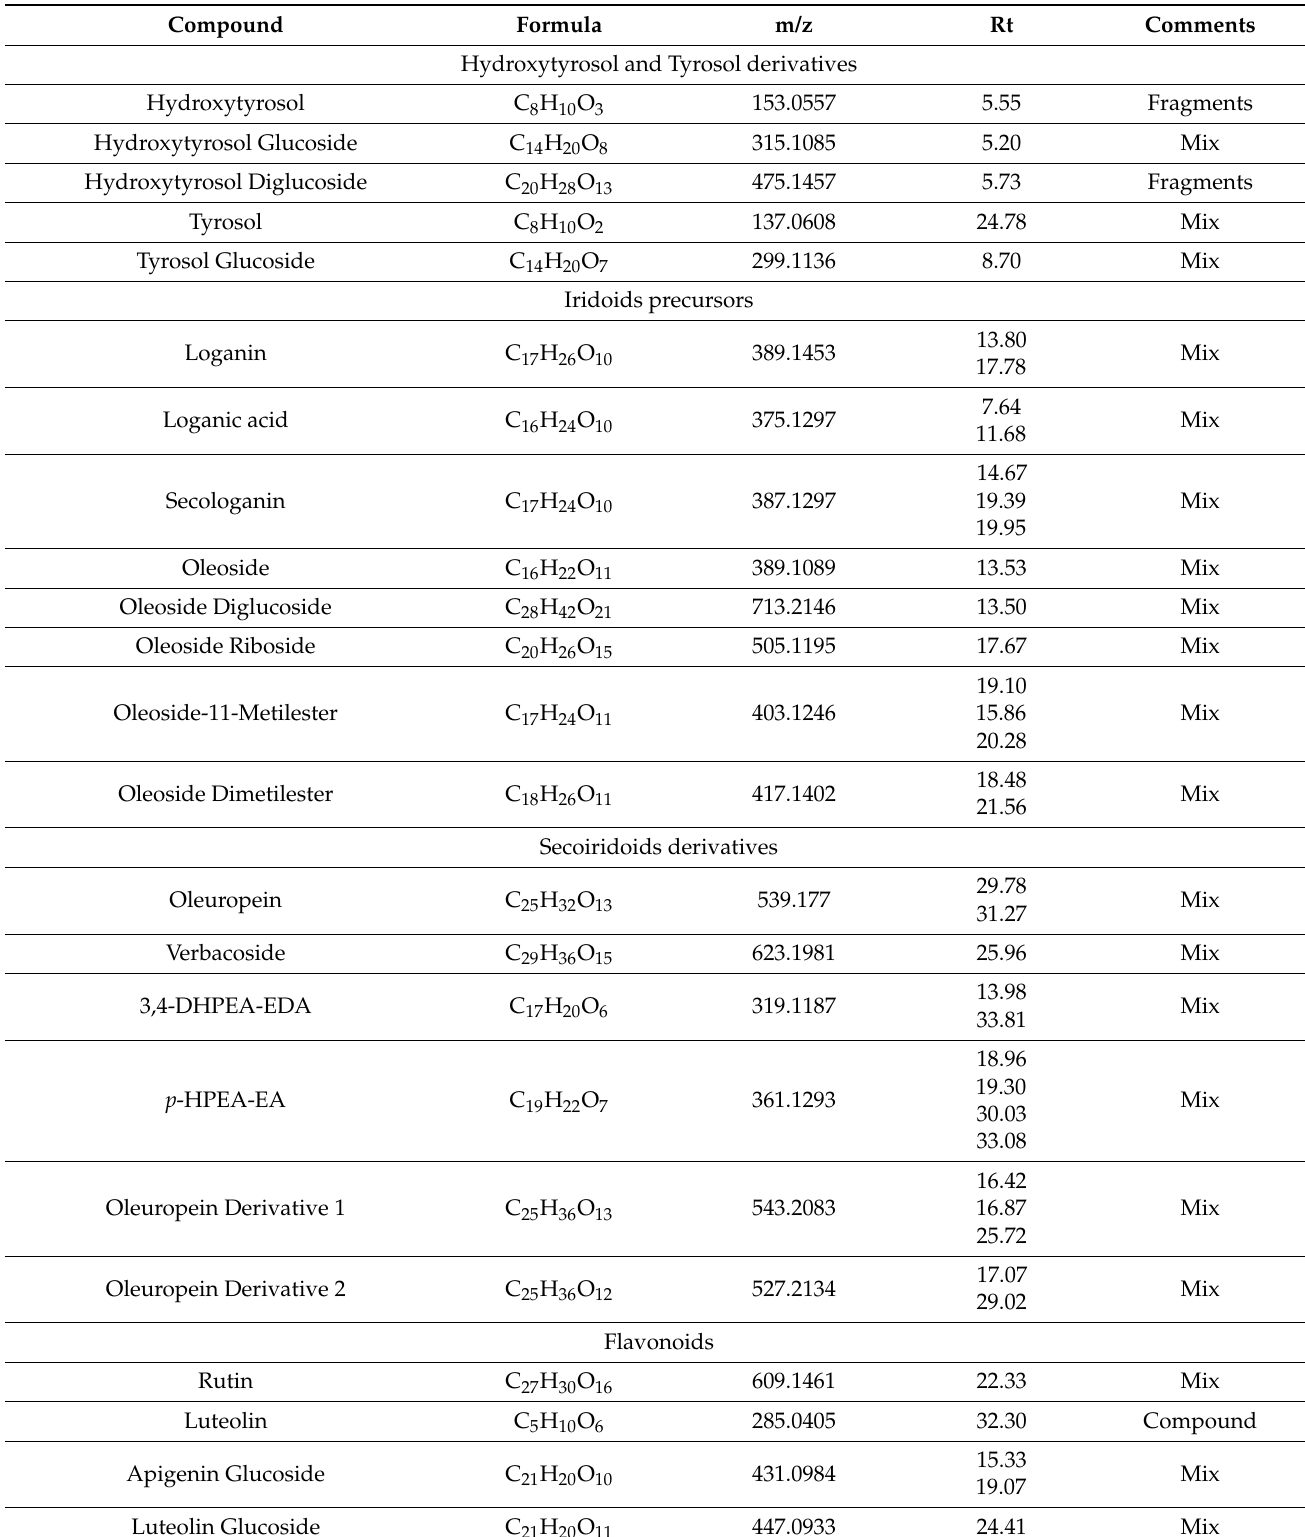
Table 6. Identification of polyphenolic compounds in olive pulp by